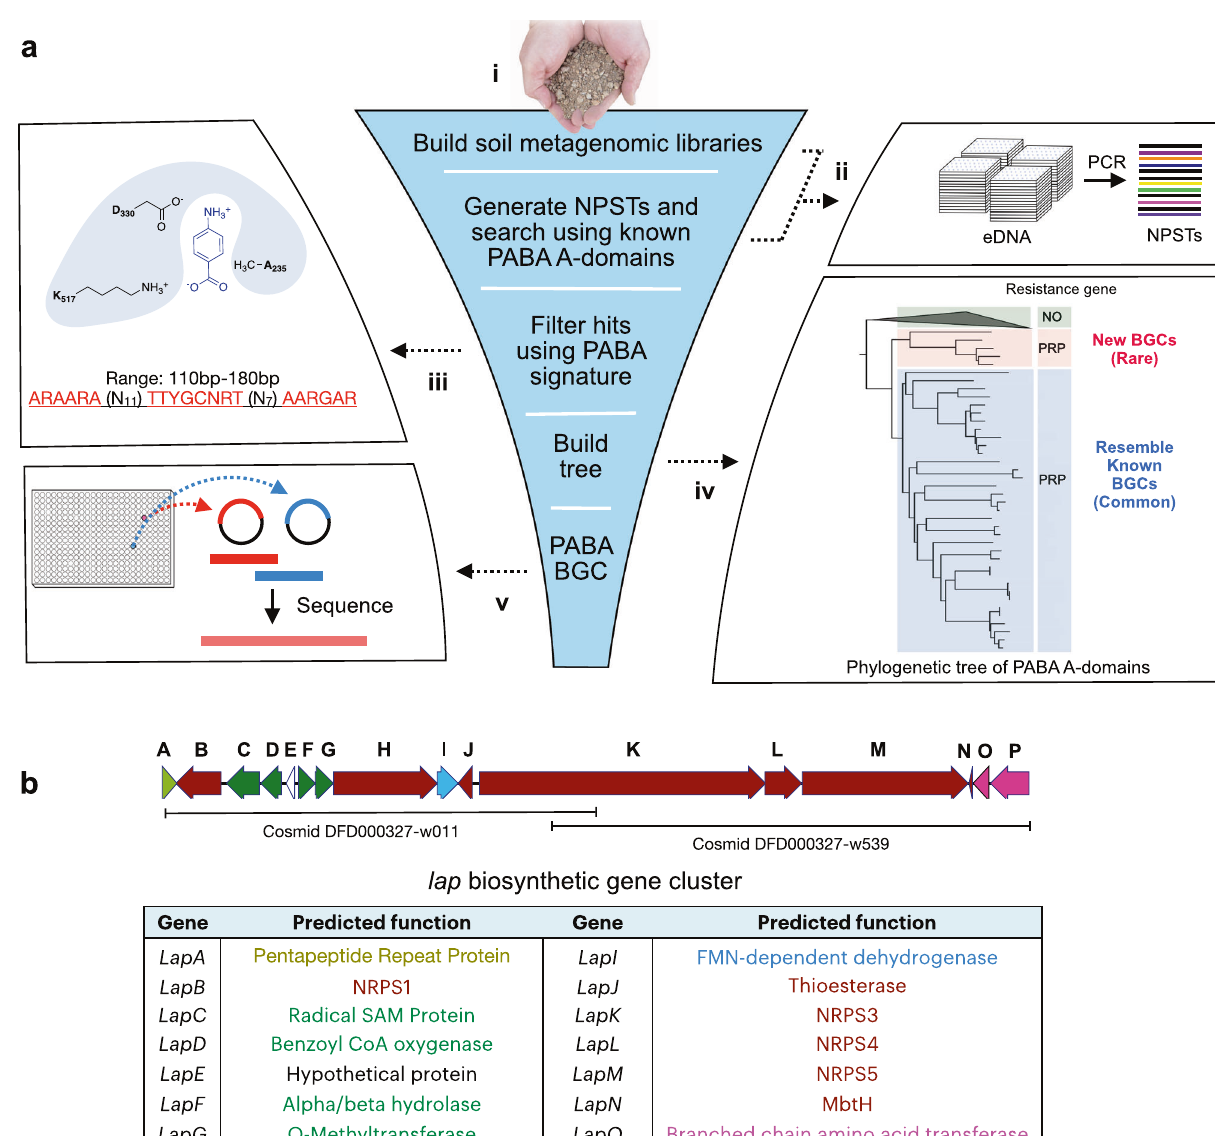
Fig. 1 Discovery of the lap gene cluster. a Overview of the PABA-speci fi c A-domain guided discovery of the lapcin ( lap ) BGC from the soil metagenome. i DNA extracted from soil was used to construct metagenomic libraries. ii NPSTs generated from arrayed metagenomic libraries and iii the resulting NPSTs were searched for PABA-speci fi c A-domains based on a signature sequence derived from known PABA A-domains. iv Phylogenetic analysis of predicted PABA NPSTs was used to identify sequences that arose from a new family of BGCs. v Clones containing NRPS BGCs of interest were recovered from the arrayed library subpools and fully sequenced to reveal BGCs that encode PABA-based natural products. b The lap BGC, which is shown here, was recovered from an archived soil metagenome library using this process. olive, resistance gene; red, NRPS biosynthesis; green, PABA tailoring; blue, thiazole formation; pink, PABA